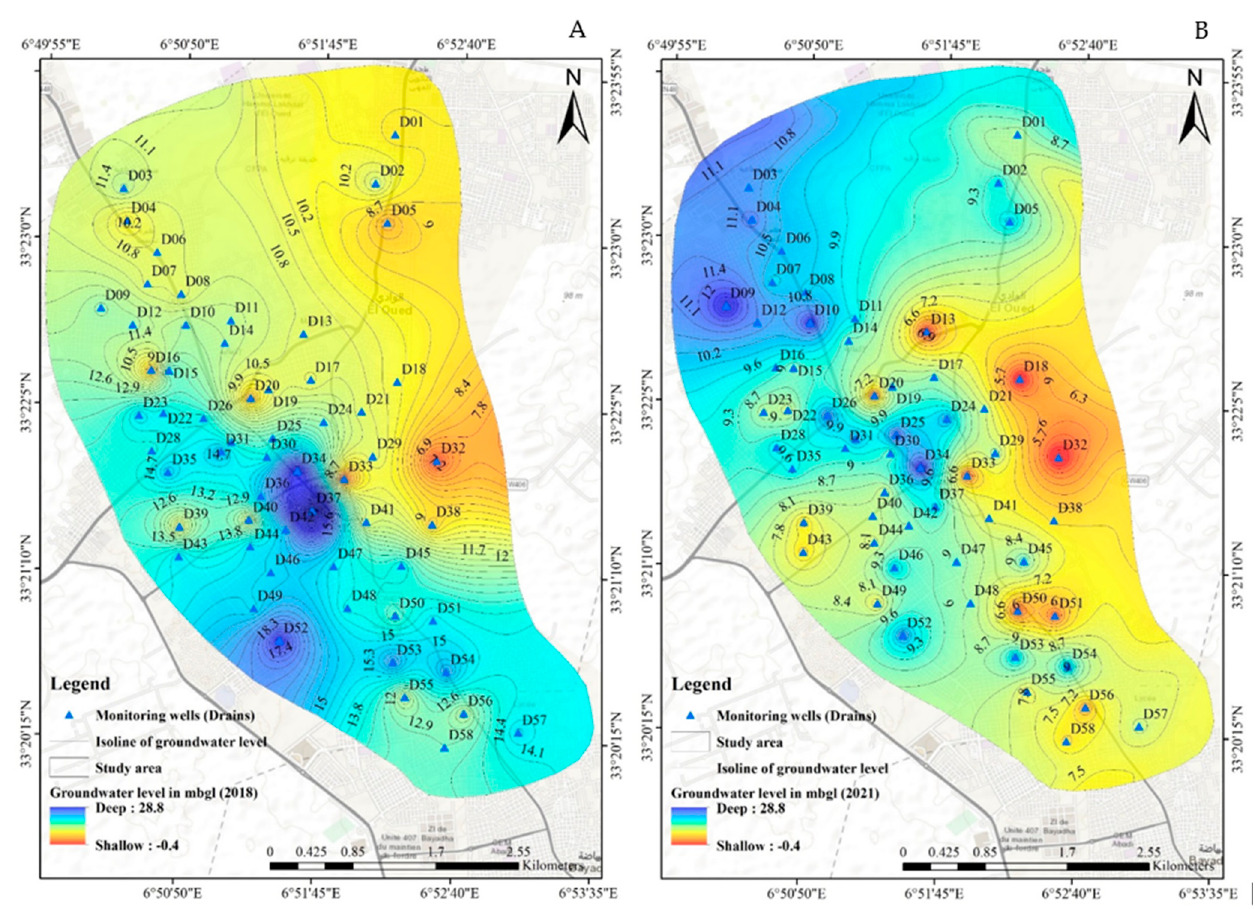
Figure 11. Spatial distribution maps: ( A ) 2018, ( B ) 2021.